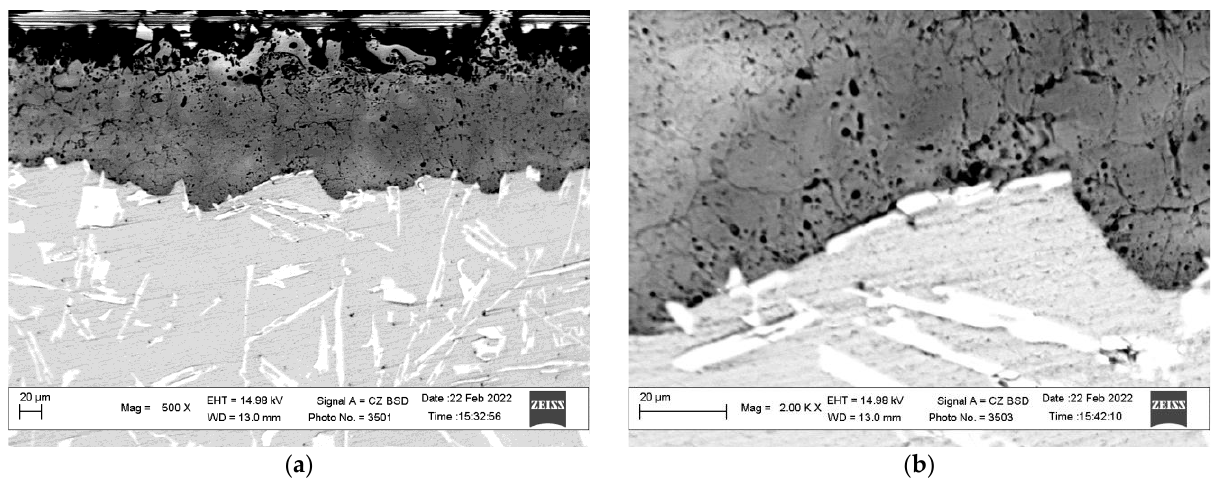
Figure 13. Structure of a PEO layer at low ( a ) and higher ( b ) (instead different) resolutions synthe- sized on the AK12 alloy in a slightly alkaline electrolyte of 3 g/L KOH + 2 g/L Na 2 SiO 3 + 3 g/L H 2 O 2